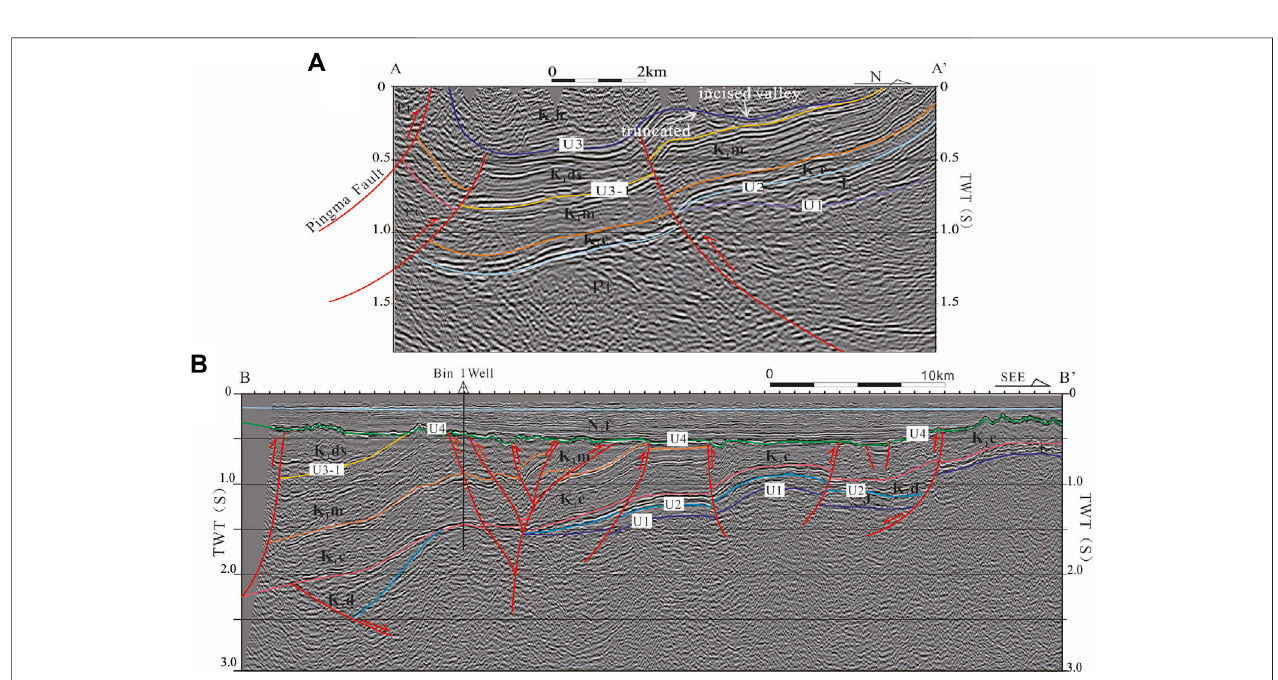
FIGURE 3 | Geological interpretations of seismic re fl ection pro fi les A-A ’ and B-B ’ (after Zhao et al., 2017) showing fi ve unconformities (i.e., U1, U2, U3, U3-1, and U4). (A) showing four unconformites in Mesozoic. (B) showing fi ve unconformites. Furthermore, these pro fi les show atransition from fault (half) graben ofthe K 1 d period to a depression of the K 1 c and K 1 m periods. Symbols and abbreviations: J 2-3 , Middle-Upper Jurassic; K 1 , Lower Cretaceous; K 2 , Upper Cretaceous; K 1 d , Didao Fm;